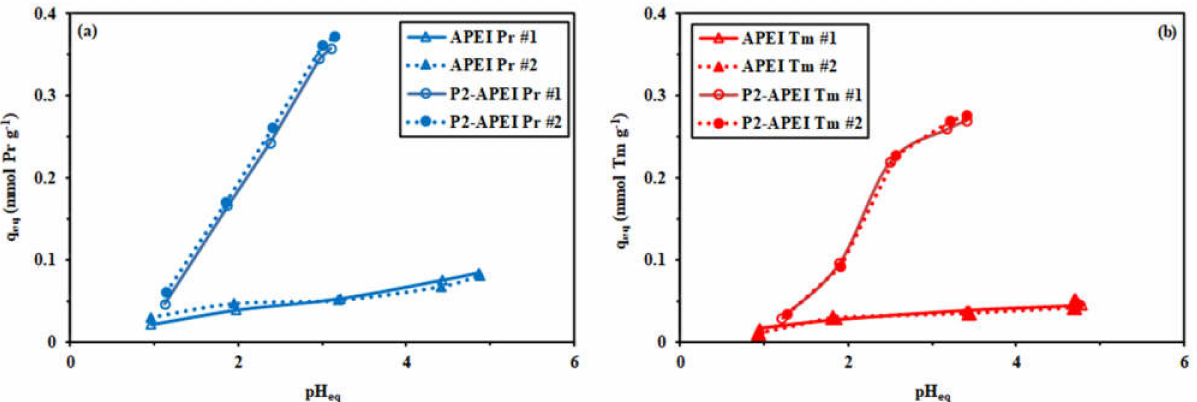
Figure 4. Effect of equilibrium pH on the sorption of Pr(III) ( a ) and Tm(III) ( b ) using APEI and P2-APEI sorbents (C 0 : 50 mg L − 1 ; Sorbent dosage, SD: 1 g L − 1 ; Contact time: 48 h; T: 22 ± 1 ◦ C; duplicate